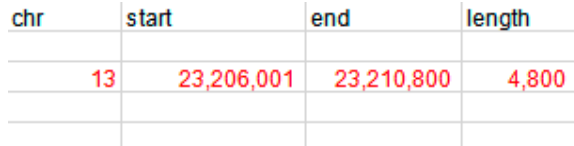
Figure 1. The region of the MTTL10 gene copy number variation (CNV) in bovine genome. The copy number variation region of the MLLT10 gene is located at Chr13:23, 206,001 to 23,210,800 bp of the MLLT10 gene, a total of 4800 bp.